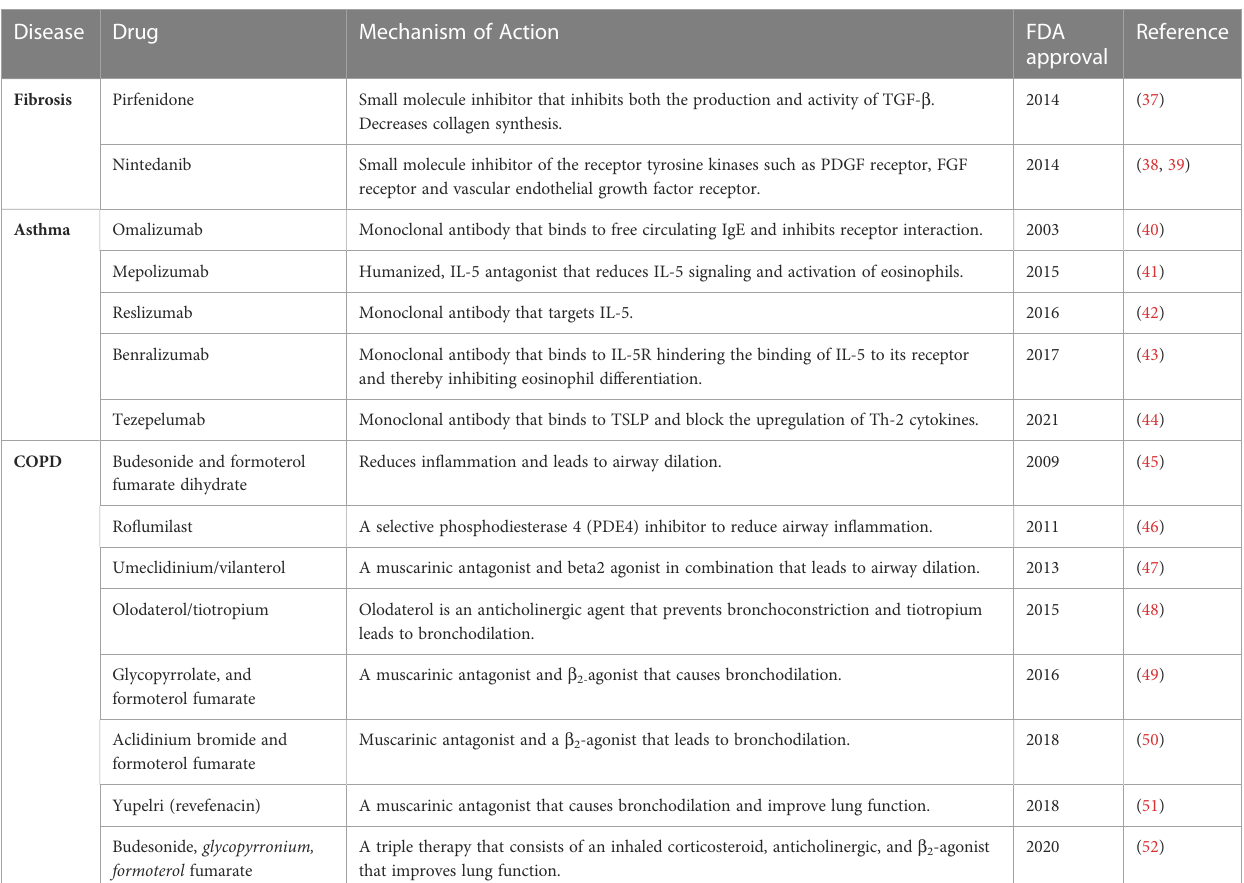
TABLE 2 Summarizes FDA approved drugs to treat fi brosis, Asthma, and